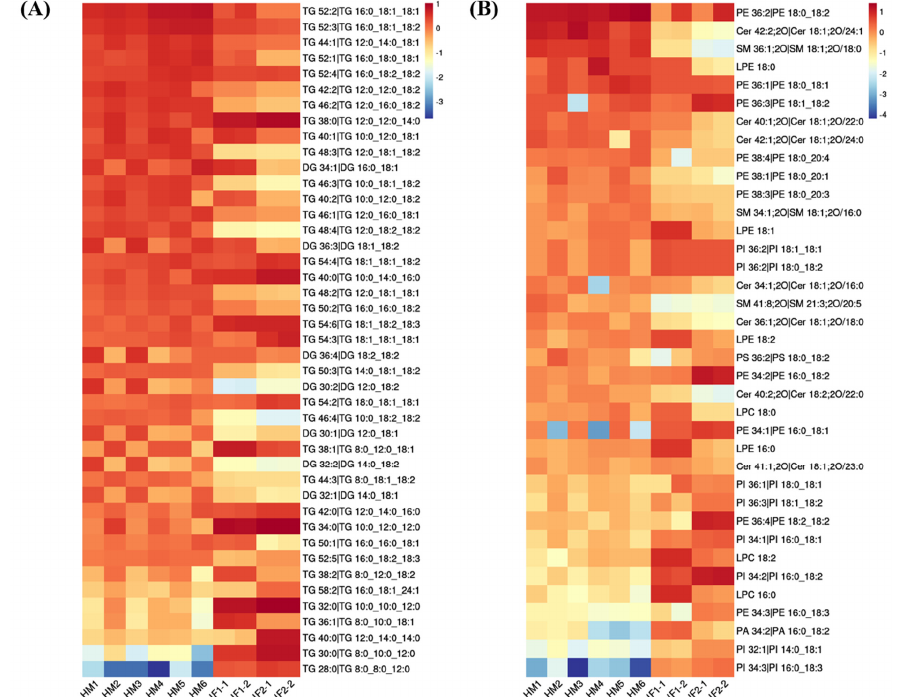
Figure 4. Heatmaps analysis of major common lipids in POS ion mode ( A ); and NEG ion mode ( B ).